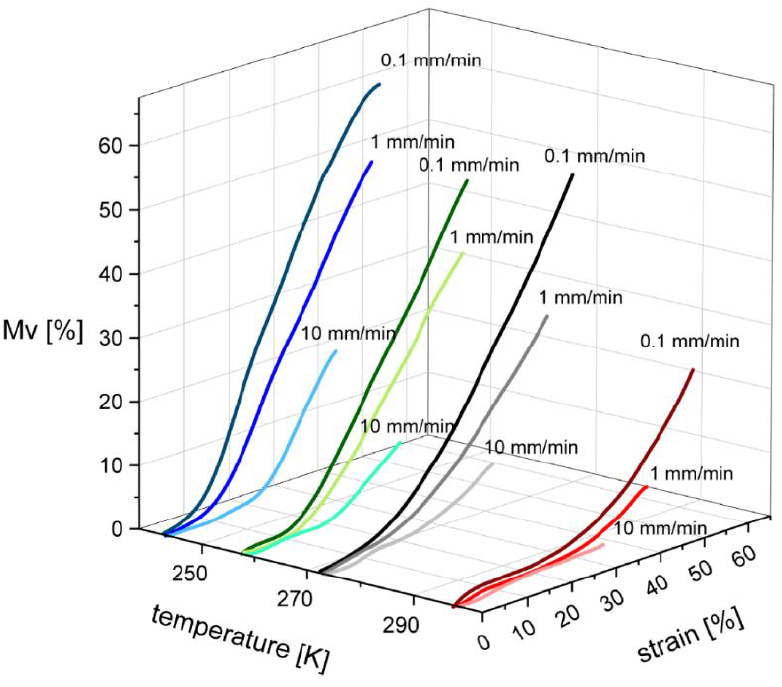
Figure 4. Relationship among ambient temperature, strain, strain rate, and α’ -martensite volume fraction (Mv) for the chemical composition of AISI 304.